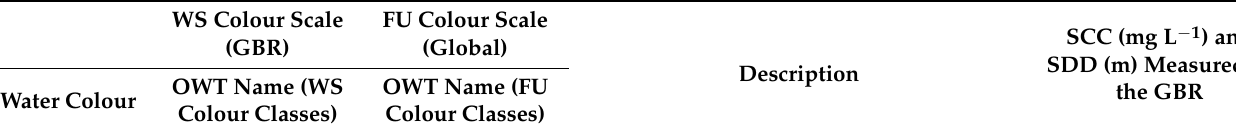
Table 2. Comparison between WS and FU OWTs and long-term SCC and SDD concentrations measured in the GBR [modified from